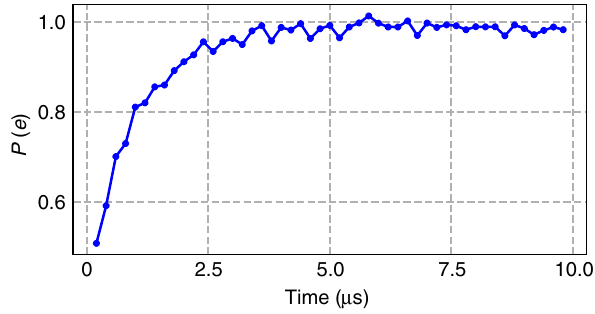
FIG. 7. The population in the j e i state as a function of the length of the reset pulse. The population is measured after simultaneously driving the j g 0 i → j h 0 i and j h 0 i → j e 1 i tran- sitions for different lengths of time. Reset of the state is achieved in approximately 5 μ s.